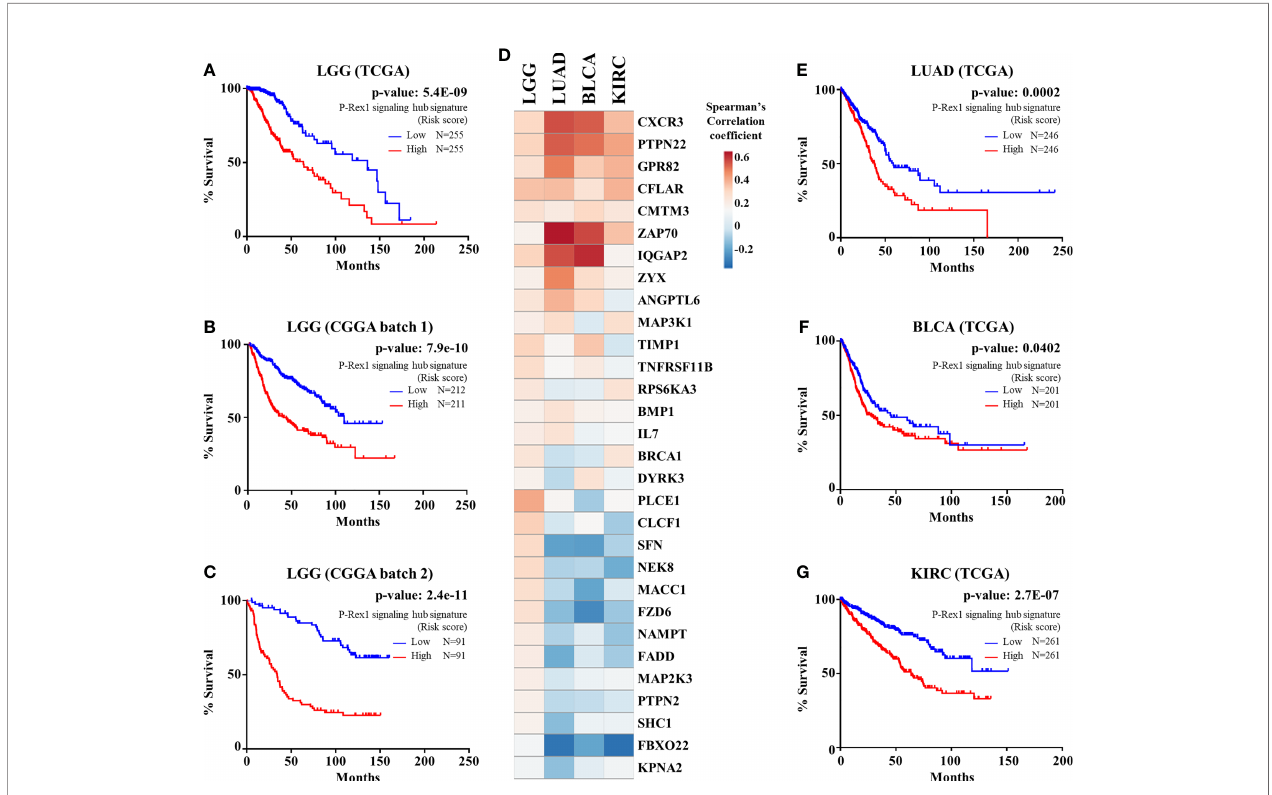
FIGURE 5 | PREX1 signaling hub validation in independent datasets. (A) Overall survival of LGG patients of the TCGA study based on the risk score de fi ned by the PREX1 signaling hub signature. (B, C) The predictive value of the PREX1 signaling hub signature, discovered in the LGG dataset of the TCGA study, was validated with independent LGG datasets of the CGGA study: (B) , batch 1, and (C) , batch 2. (D) Comparative coexpression of PREX1 and its signaling partners, that constitute the PREX1 signaling hub signature, among LGG, LUAD, BLCA, and KIRC tumors of the TCGA studies (comparison among all 32 TCGA studies is shown in Supplementary Figure 1 ). (E – G) Overall survival curves of LUAD (E) , BLCA (F) , and KIRC (G) patients divided by their high and low risk scores de fi ned by the PREX1 signaling hub signature. Analysis of the overall survival of cancer patients, based on the risk score de fi ned by the PREX1 signaling hub signature, was done by the univariate Cox Proportional Hazards